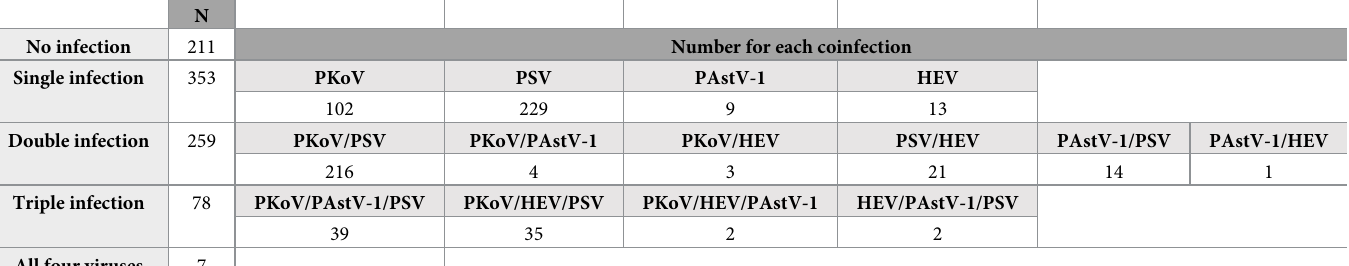
Multivariate analysis: Associated factors identified for each viral infection A multivariate logistic regression analysis was performed, and the results showed associations depending on the three viruses (Table 4). A strong association was observed between PKoV and PSV detection (OR = 3.36 [2.44–4.67]; P -value = 9.1e–15). PKoV was also associated with PAstV-1 codetection (OR = 2.16 [1.29–3.70]; P -value = 0.015) and young pigs under 4 months of age (OR = 3.11 [2.31–4.20]; P -value = 4.3e–10). PAstV-1 detection was also associated with Table 3. Coinfections in pig feces